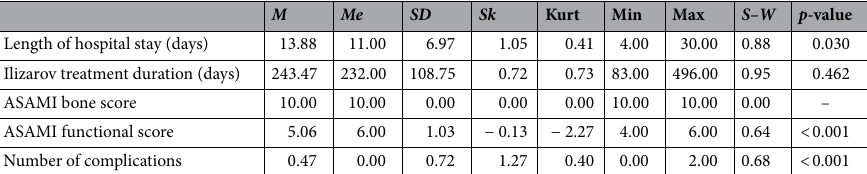
Table 6. Descriptive statistics and Shapiro–Wilk test results for quantitative variables in the patients who underwent open fixation procedures with subsequent continued compression (n = 17). M mean, Me median, SD standard deviation, Sk. skewness, Kurt. kurtosis, Min minimum, Max maximum, S–W Shapiro–Wilk test result, p-value significance of normality of